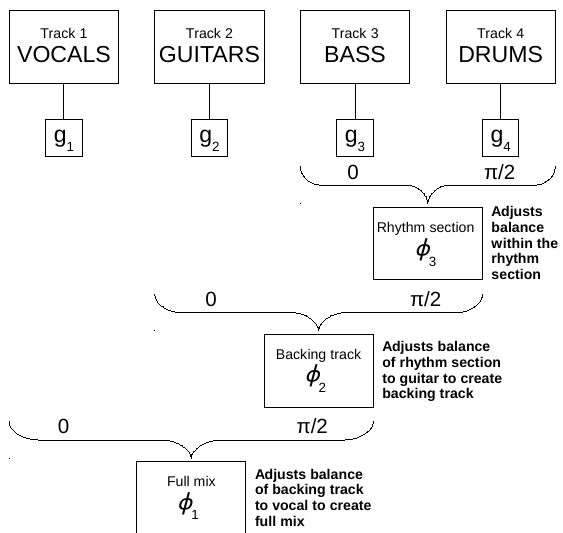
Figure 3. Schematic representation of a four-track mixing task, with track gains g 1 , g 2 , g 3 , g 4 , and the semantic description of the three φ terms, when adjusted from 0 to π /2. Figure taken from [7].